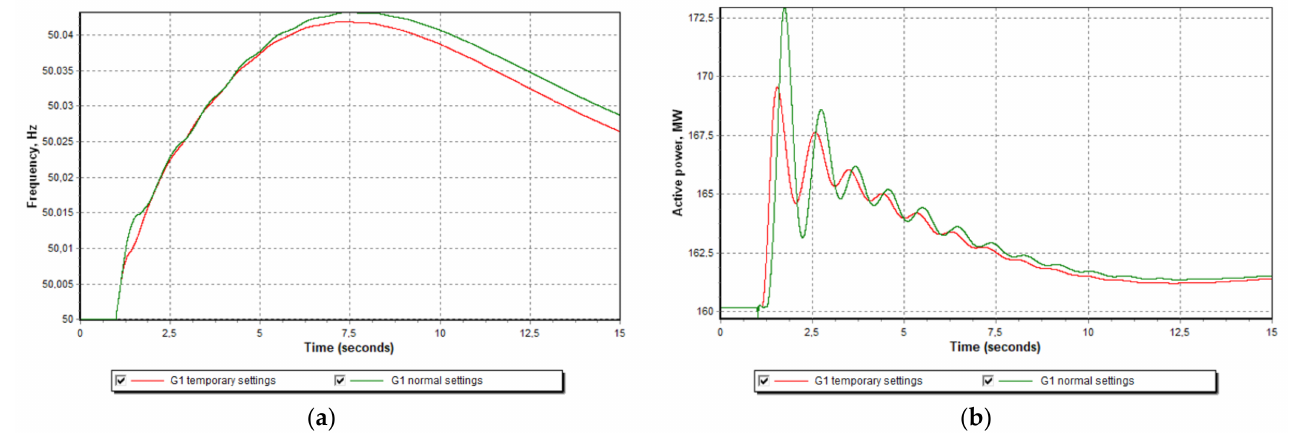
Figure 17. ( a ) Frequency change in the isolated power system in response to SC disconnection.